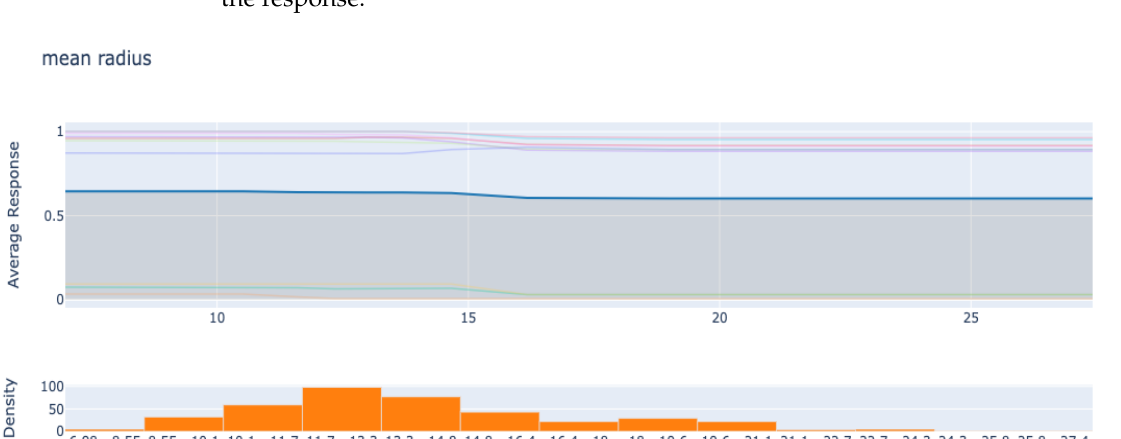
Figure 7. Interpreting a prediction with the post hoc XAI method: LIME. The x-axis shows the fea- ture effect.